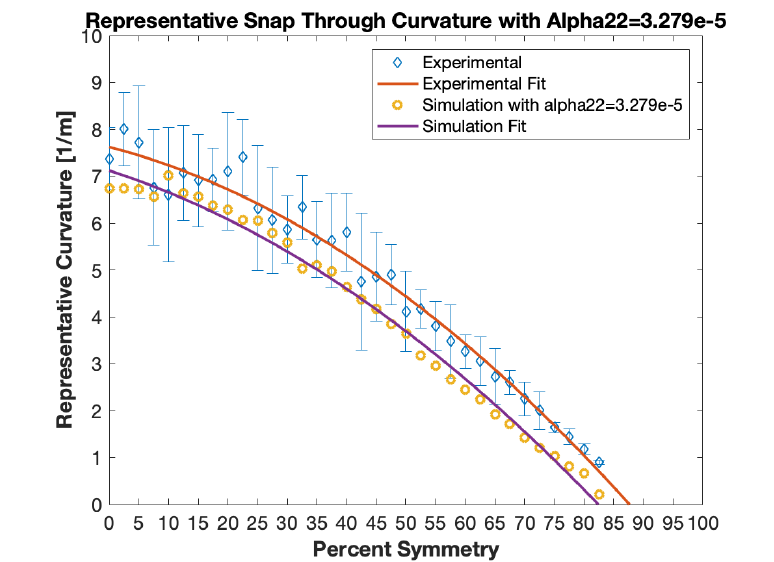
Figure 14. The snap through curvature versus the percent symmetry for all of the laminates simulated and studied that were bistable, using an α 22 value of 3.279 × 10 − 5 . Error bars on the experimental points show ± one standard